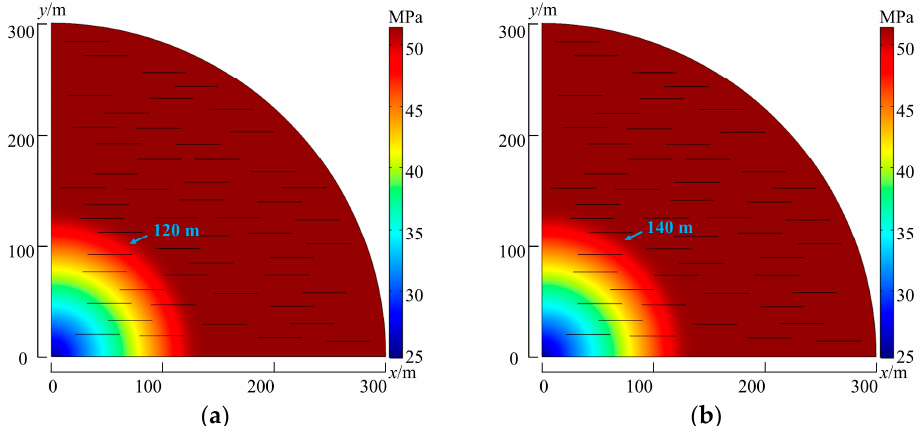
Figure 10. Formation pressure distribution under different fracture permeabilities. ( a ) k f = 1.79 mD, ( b ) k f = 3.58 mD.